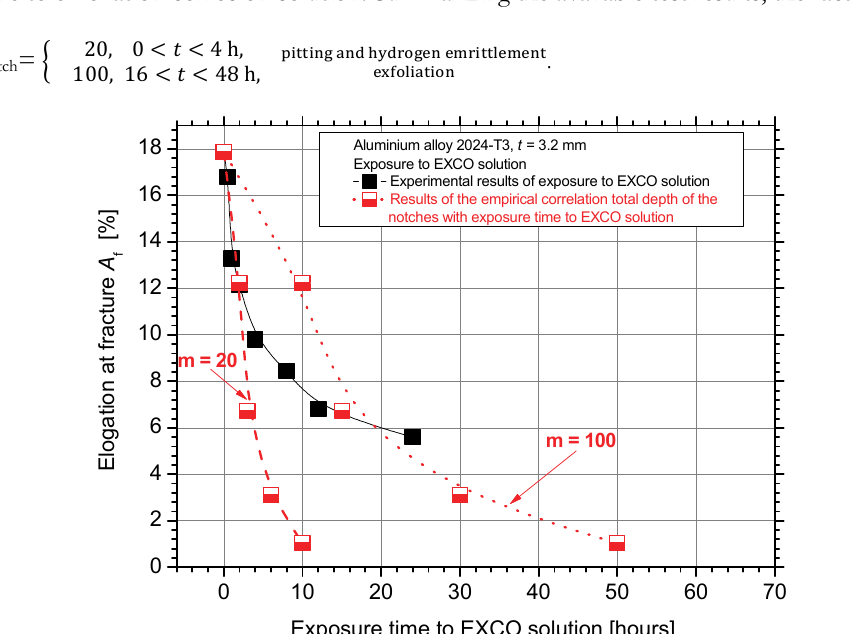
Figure 7: Correlation of the elongation at fracture A f decrease due to exposure to the EXCO solution as well as to the presence of the artificial surface